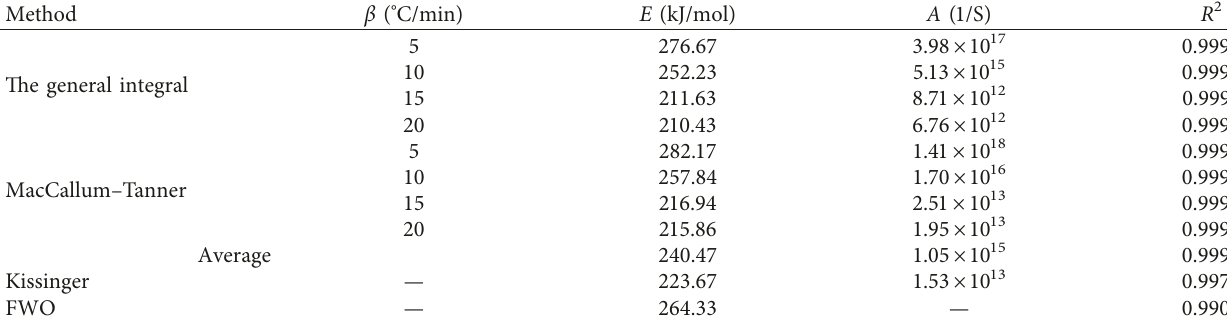
Table 6: Calculation results of coal